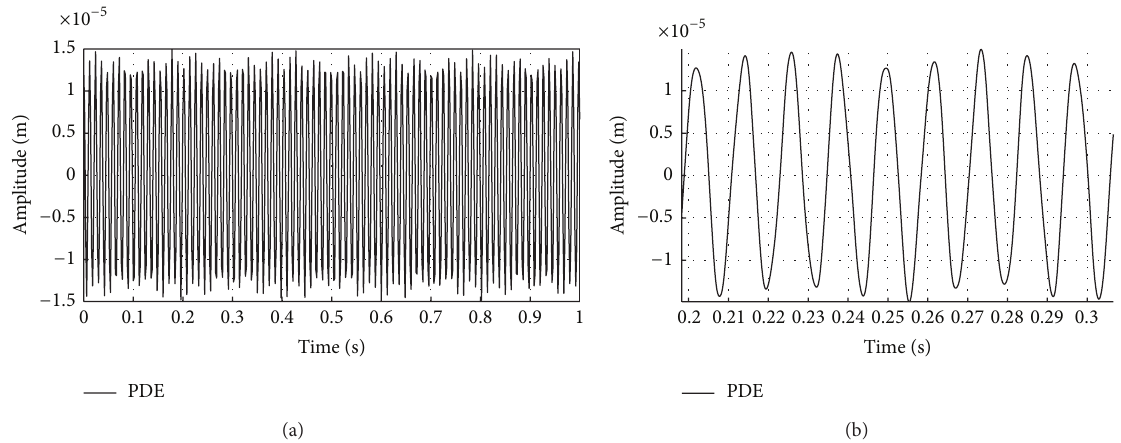
Figure 3: PDE graph simulation (a) presents the cell displacement (𝑏/ 2 , 𝑏/ 2 ) on the 𝑧 -axis; (b) zoom-in of the PDE simulation graph.